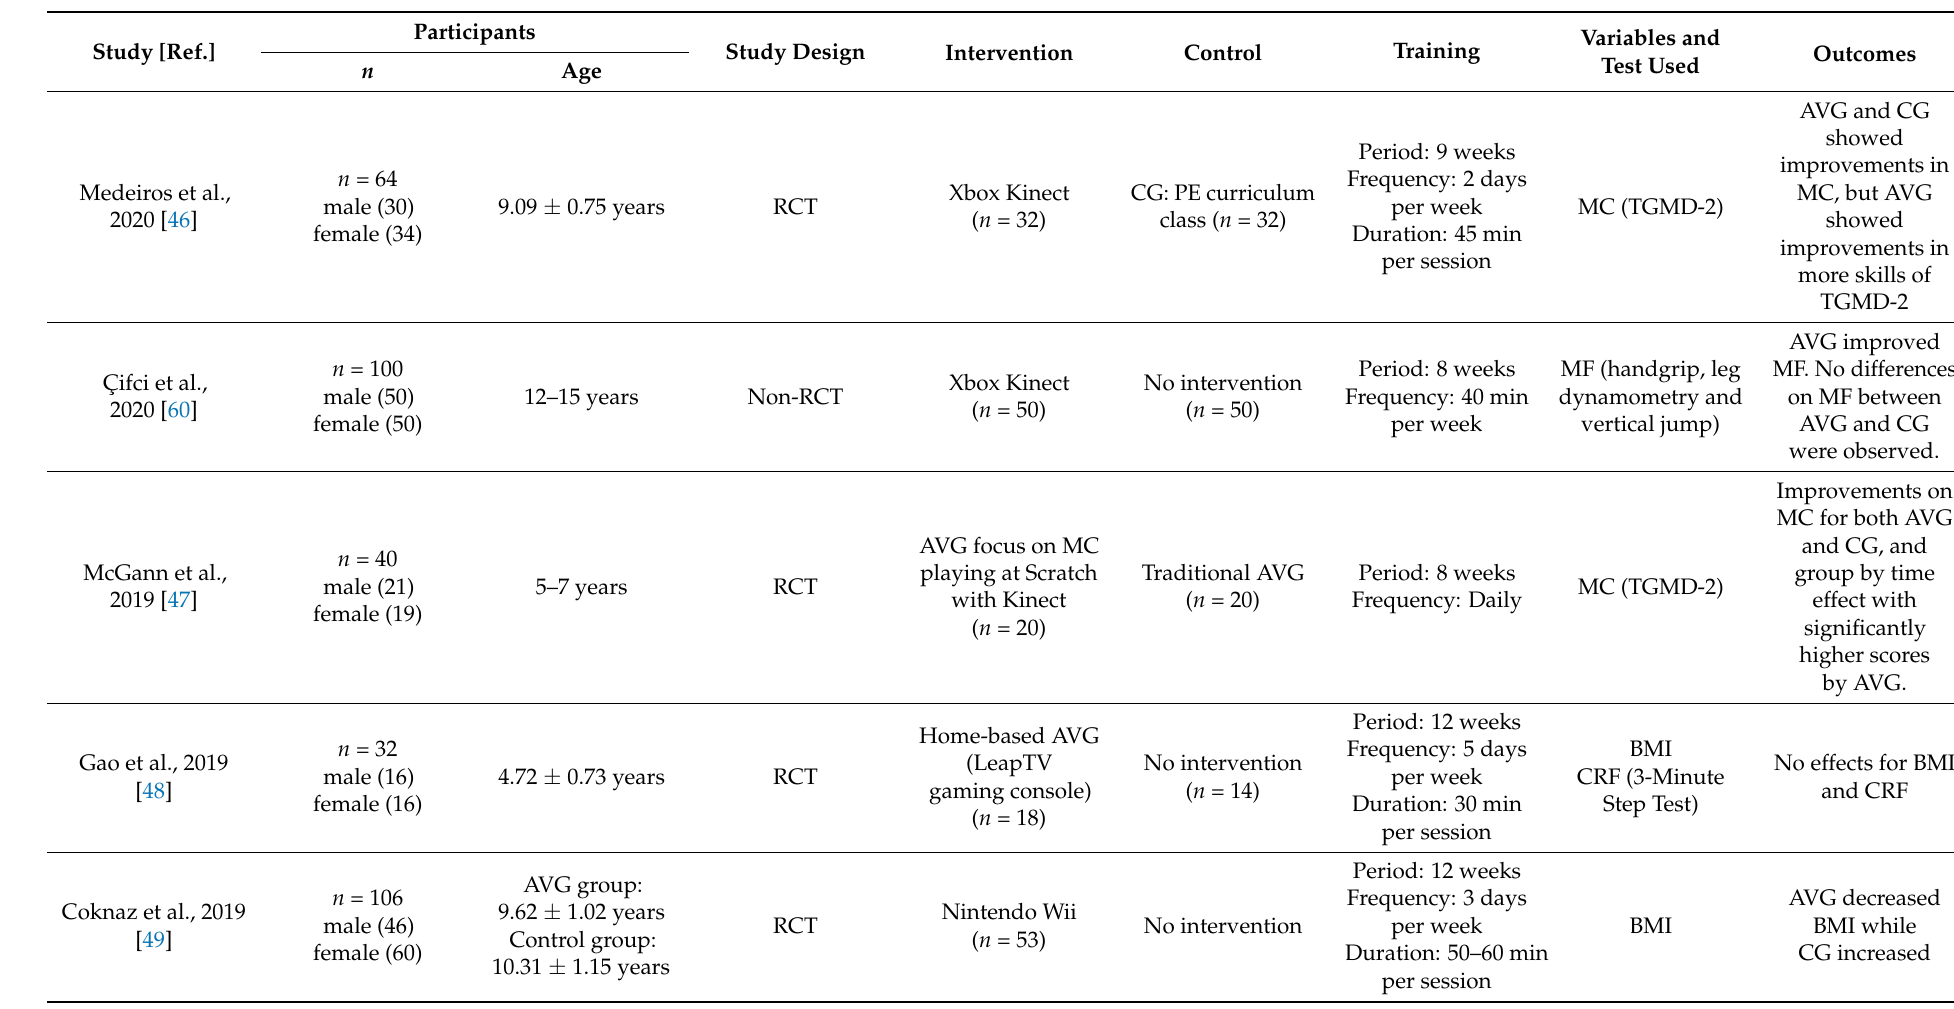
Table 3. Descriptive characteristics of included studies with children with healthy